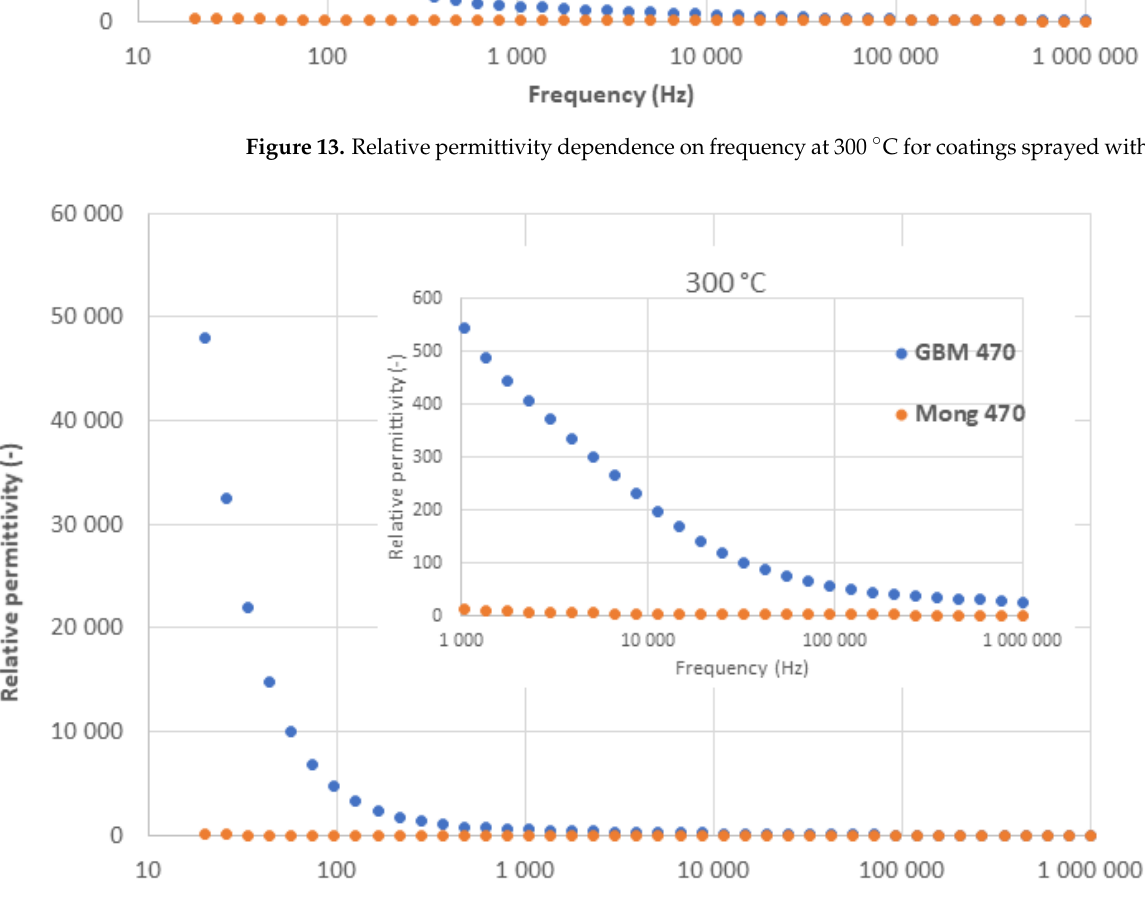
Coatings 2022 , 12 , x FOR PEER REVIEW